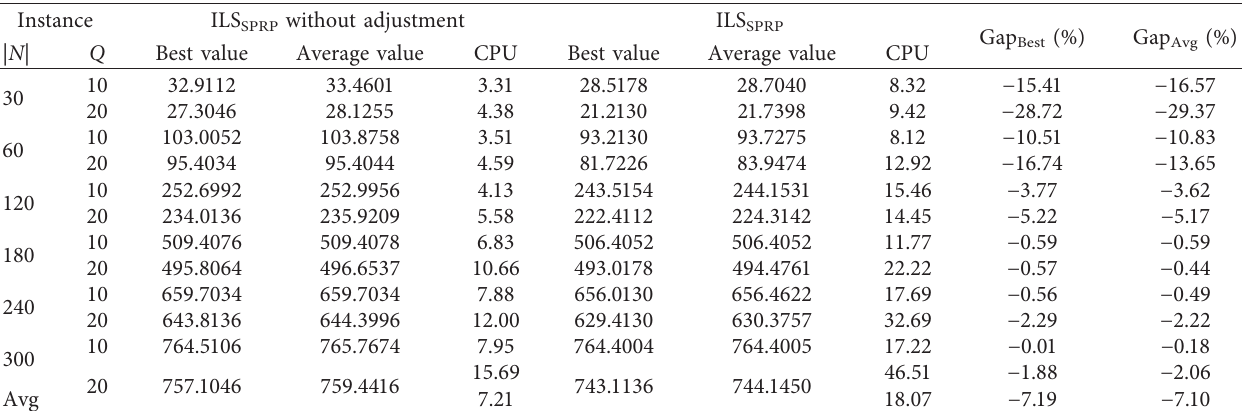
Table 7: Result comparison of ILSSPRP with and without the adjustment operator ( T � 21600s).